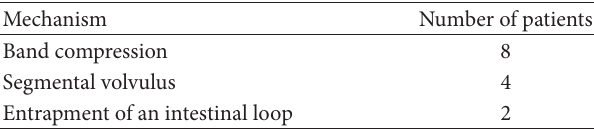
Table 2: The mechanism of intestinal